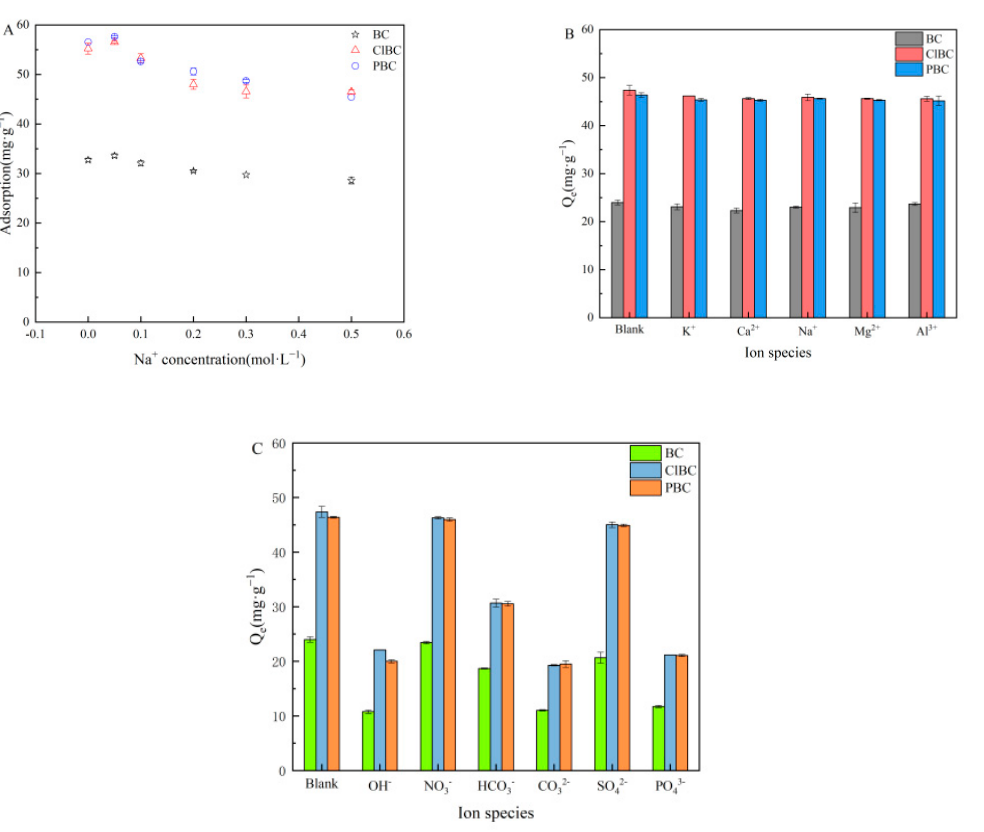
Figure 7. Effect of ionic strength and types. ( A ) ionic strength; ( B ) cations; ( C ) anions.